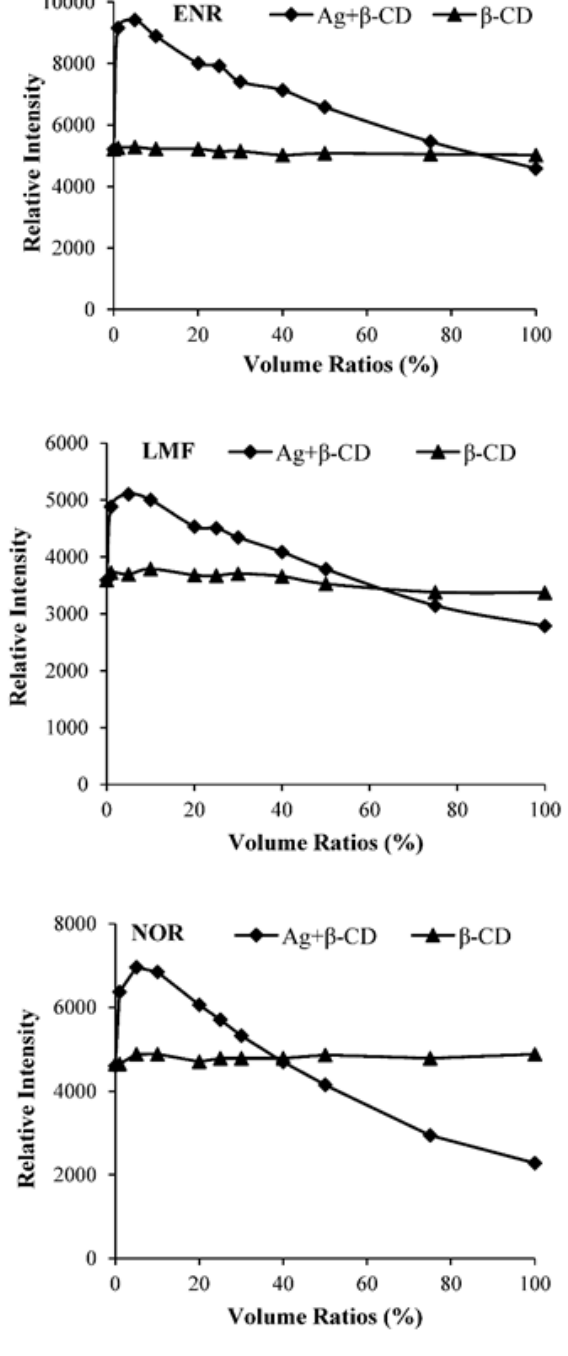
Figure 5: Effects of different volume ratios of β-CD and the mixture of AgNPs and β-CD on the relative fluorescence intensities of each FQ.